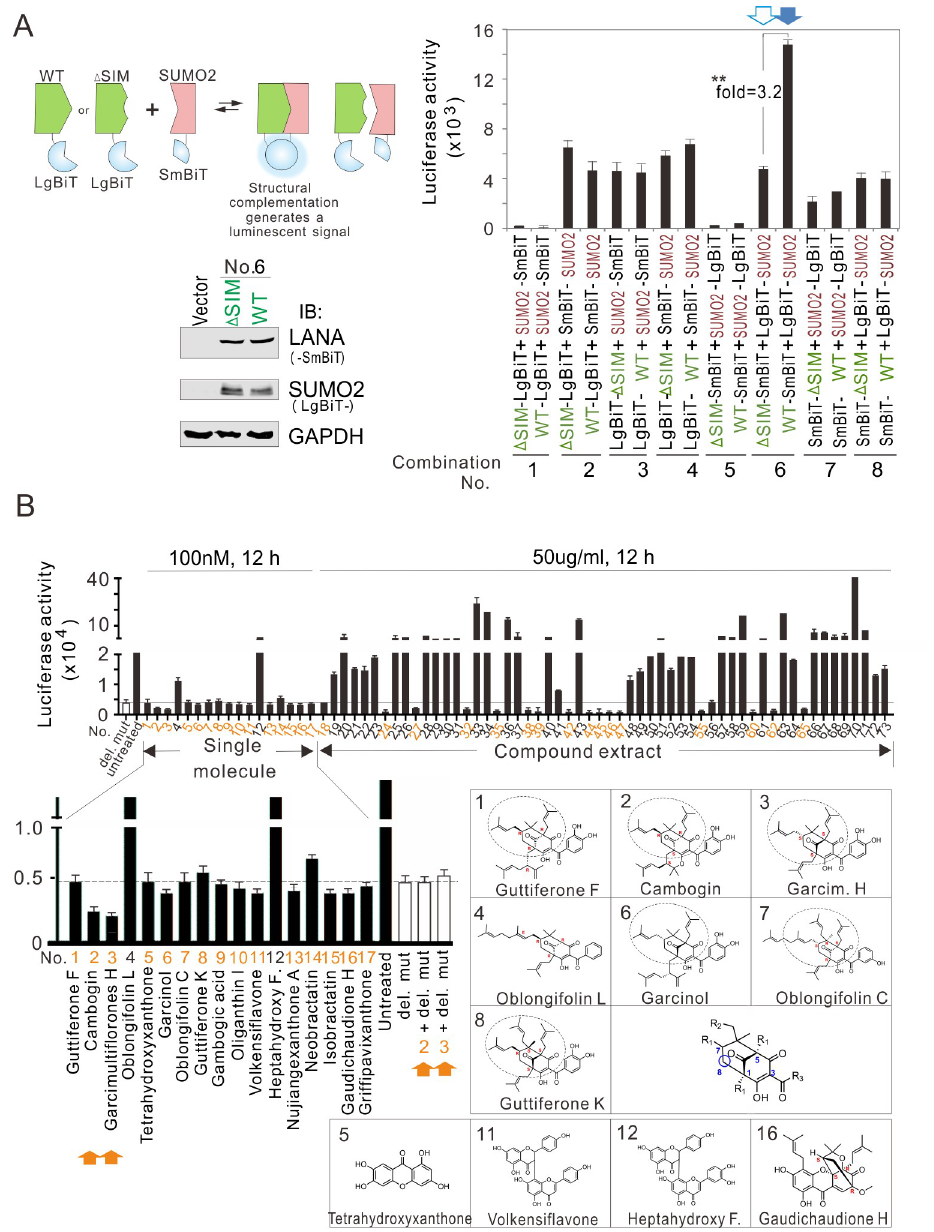
Fig 1. Identification of small molecules that block the intracellular interaction of viral SIM and SUMO2. ( A ) Establishment of a live-cell system for quantitatively measuring the intracellular interaction of viral SIM and SUMO2 using NanoLuc Binary Technology. HEK293 cells were individually transfected with different combinations of wild- type (WT) LANA [or its SIM-deleted ( Δ SIM) mutant] and SUMO2 fusion with large or small fragments of BiT (LgBiT or SmBiT) for 48 h, incubated with Nano-GloR reagent, and luminescence was measured. Among the eight combinations, the luciferase activity of the WT LANA-SmBiT and LgBiT-SUMO2 combination (arrow) exhibited the highest level in three-independent experiments. The effect was dramatically abolished by deletion of the SIM motif. Left panels , the schematic for establishing the live-cell system to quantitatively measure the intracellular interaction of viral SIM and SUMO2. Bottom panels , the immunoblotting analysis of cell lysate from combination No. 6 transfection along with vector alone as a control. ( B ) Representative screening of 73 compounds from Chinese herbal medicines. HEK293 cells co-transfected with WT LANA-SmBiT and LgBiT-SUMO2 were untreated or treated with each compound for 12 h. The SIM-deleted mutant ( Δ SIM) untreated or treated with compound No. 2 or No. 3 were used as a parallel control. Bottom panels , the chemical structures of representative compounds of PPAPs and Xanthones. Core skeleton of type-B PPAPs is highlighted. The details of each compound see supplementary S1 Table .